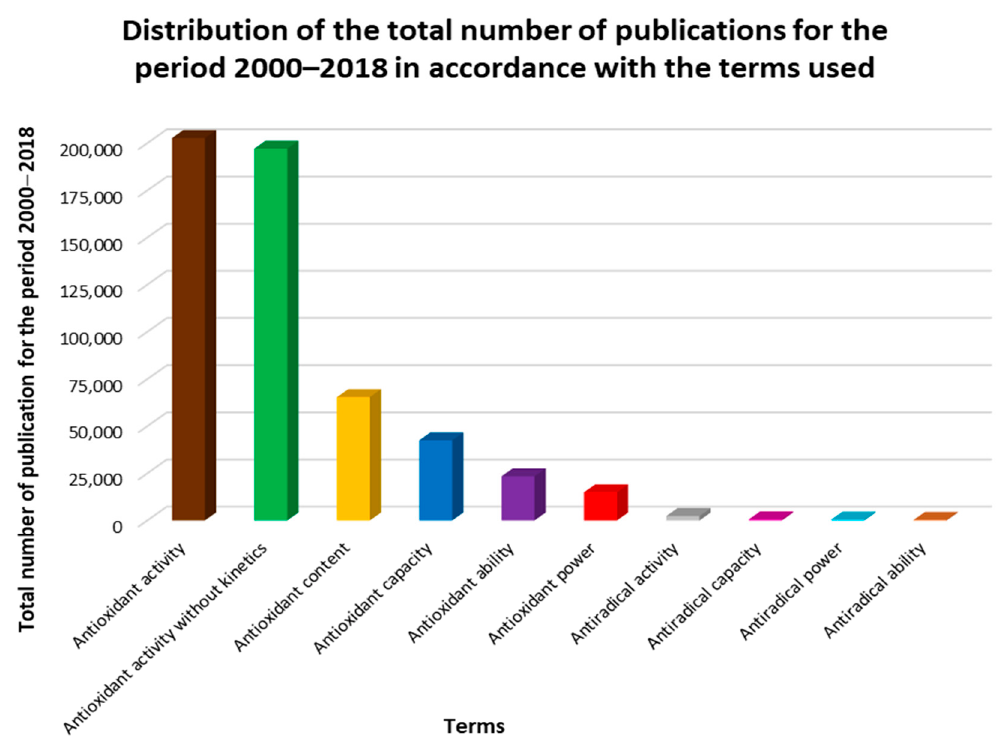
Figure 2. Frequency of terms used in